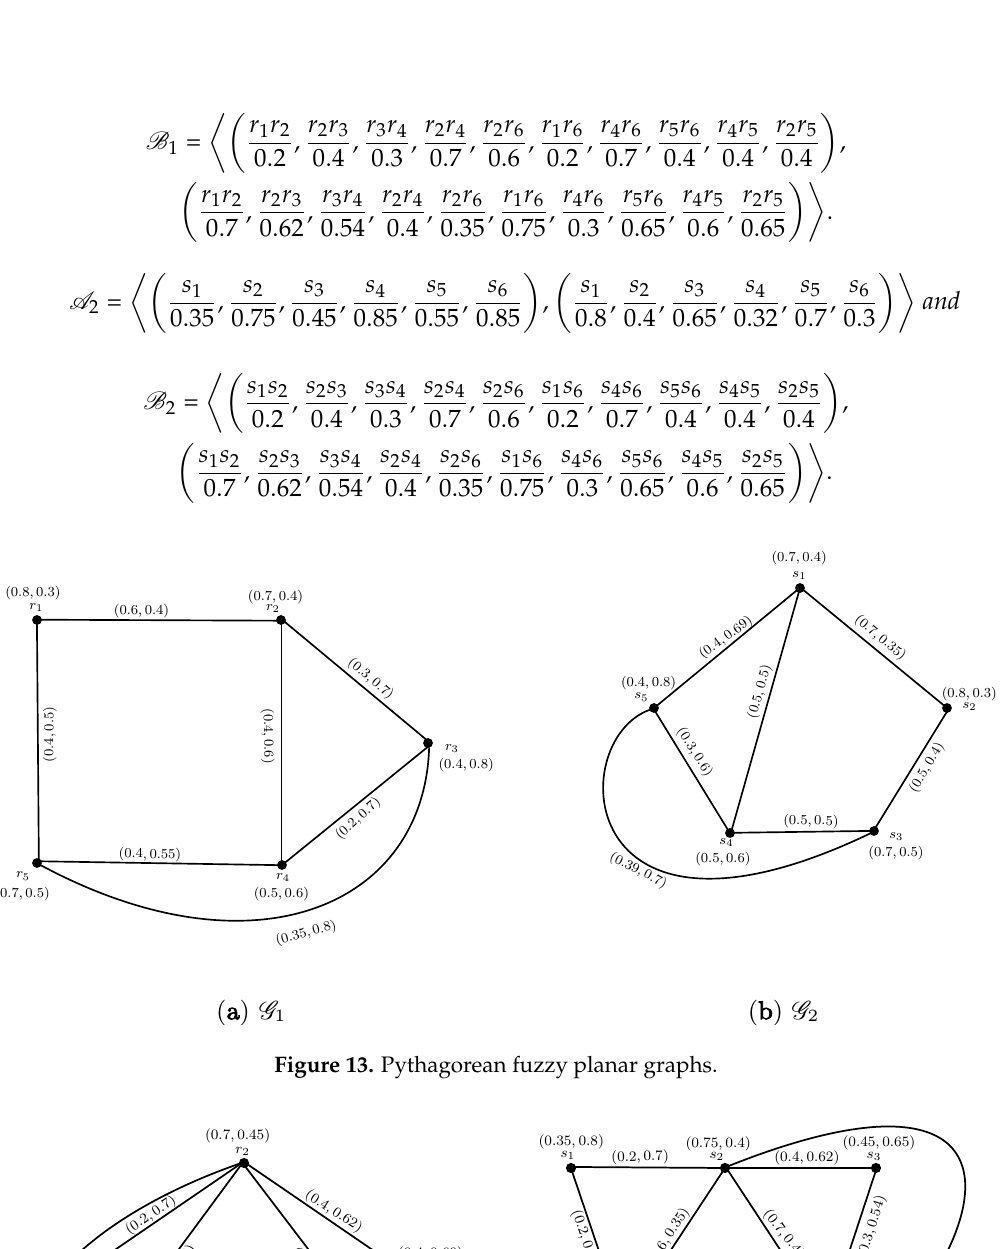
Figure 6.2: Pythagorean fuzzy planar graphs Figure 13. Pythagorean fuzzy planar graphs.